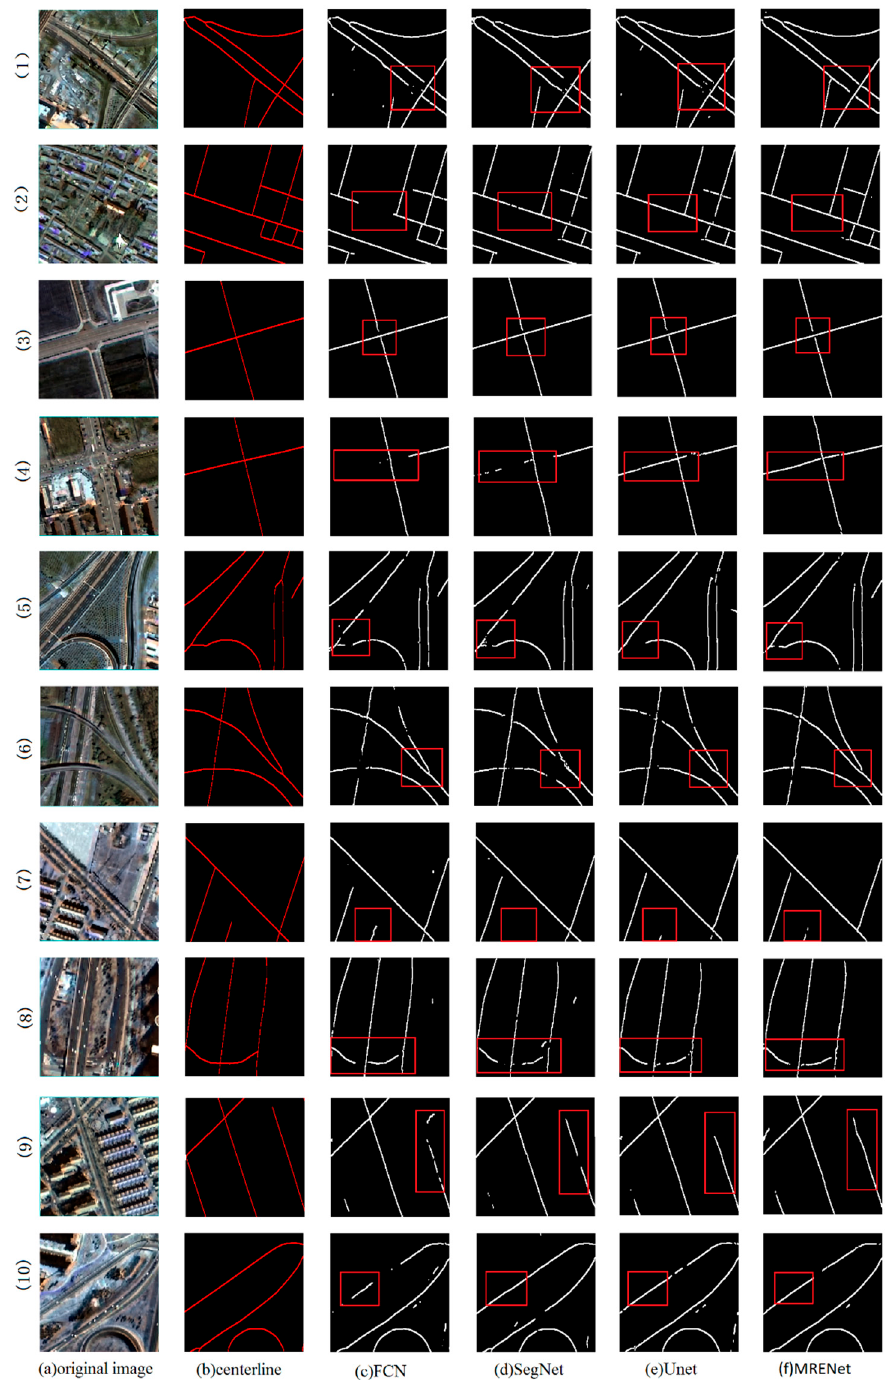
Figure 7. Visual comparisons of road centerline extraction results with different networks.